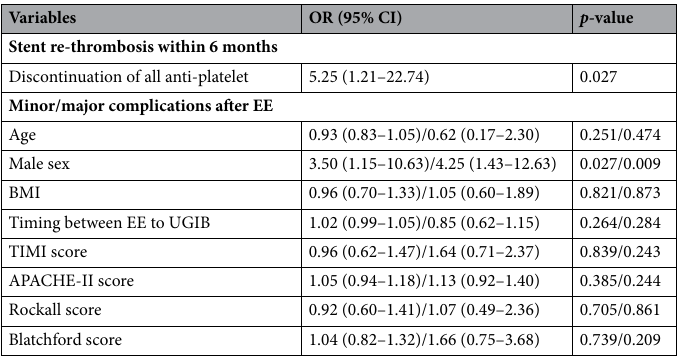
Table 4. Risk factors for complications of early endoscopy. APACHE‑II Acute Physiology and Chronic Health Evaluation-II, BMI body mass index, EE early endoscopy, TIMI Thrombolysis In Myocardial Infarction, UGIB upper gastrointestinal tract